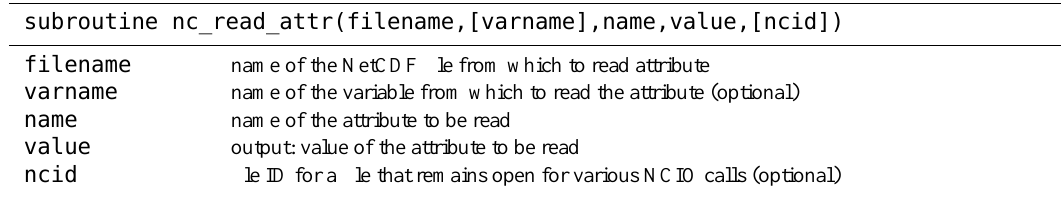
Table A3. Subroutine call and argument descriptions for nc_read_attr .